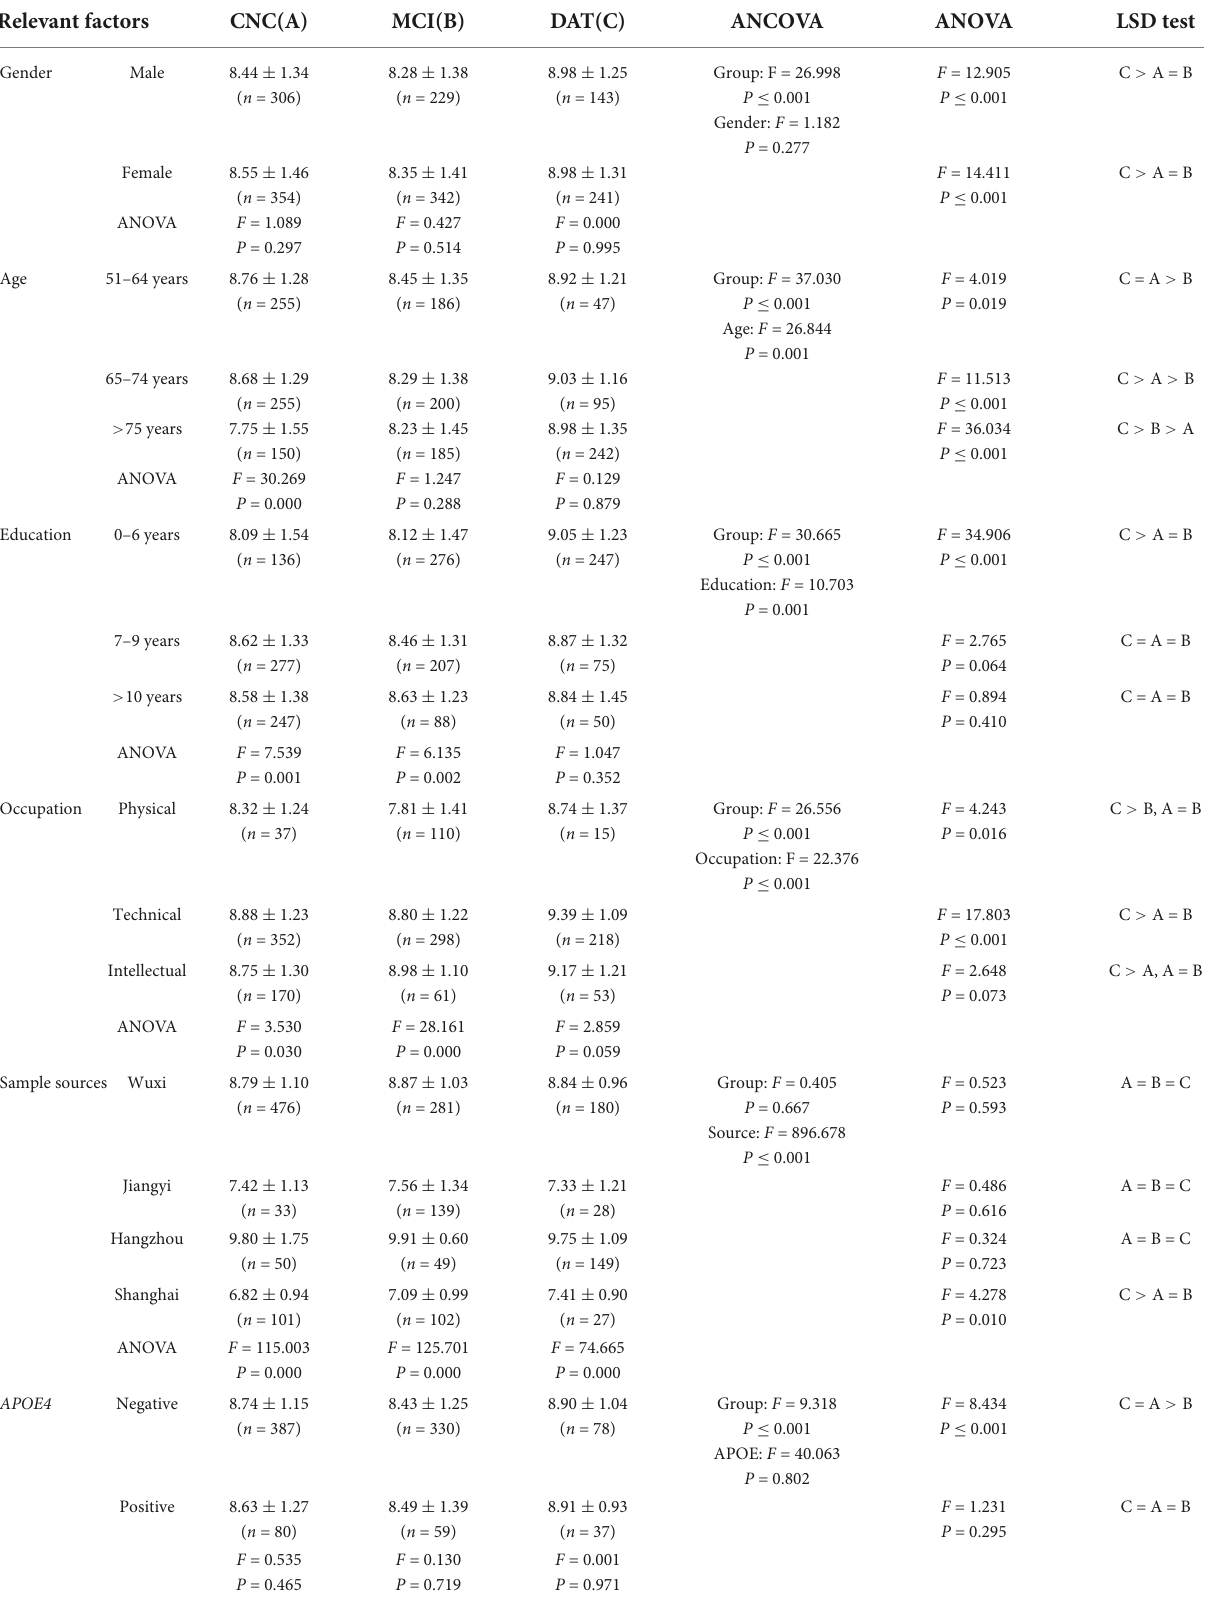
TABLE 4 Factors influencing the association between plasma BDNF and cognitive impairment. Relevant